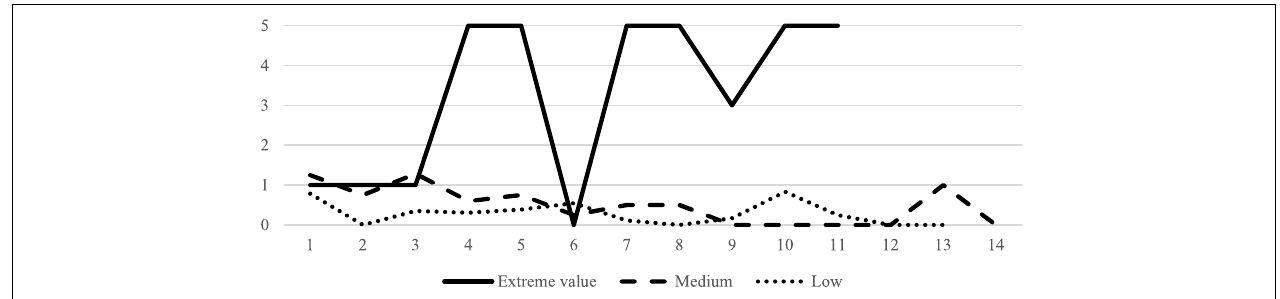
FIGURE 2 | Average number of suicidal ideations per class across time (14